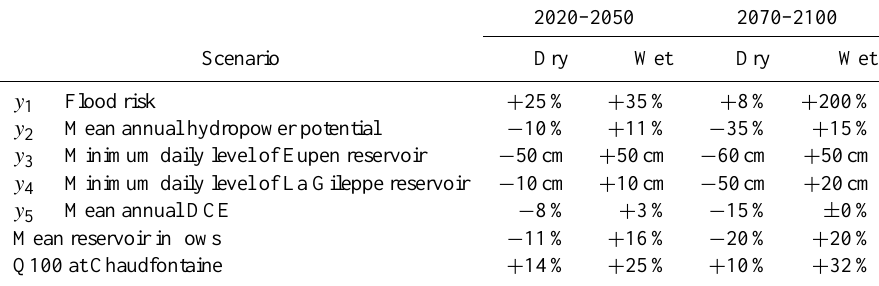
Table 8. Influence of climate change.